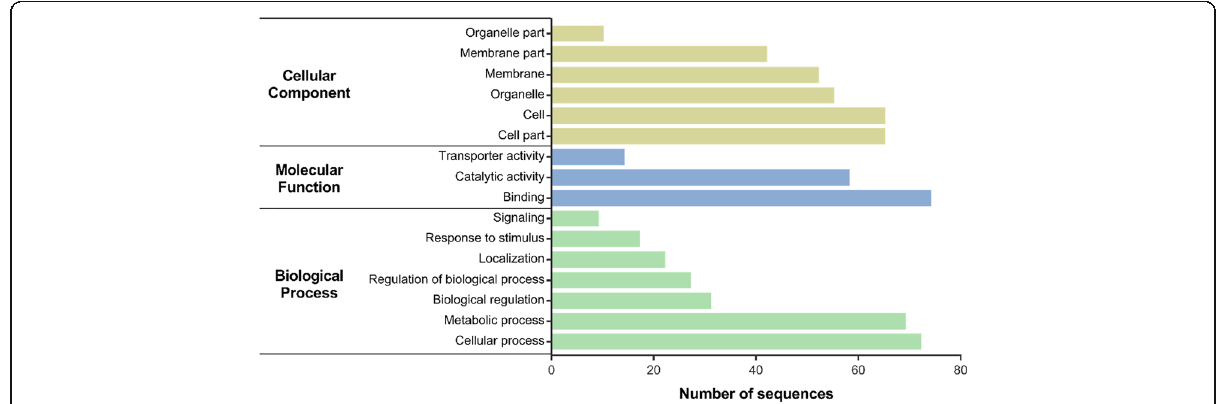
Fig. 4 Gene ontology analysis of putative target genes of the identified known miRNAs. A total of six terms in the cellular component category, three terms in the molecular function category and seven terms in the biological process category were obtained. “ Binding ” and “ Cellular process ” possessed the most genes among all the GO terms found in this